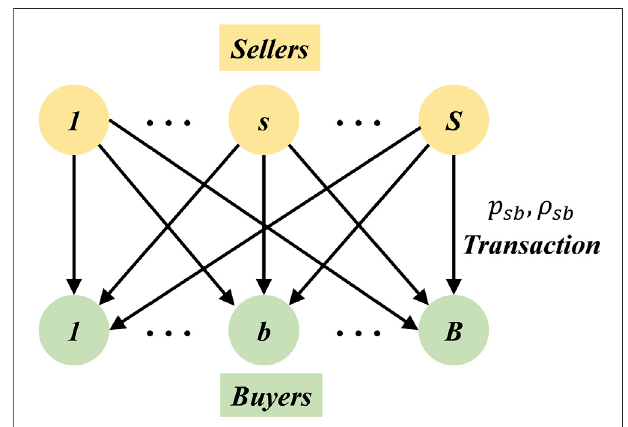
FIGURE 2 | The structure of P2P energy sharing